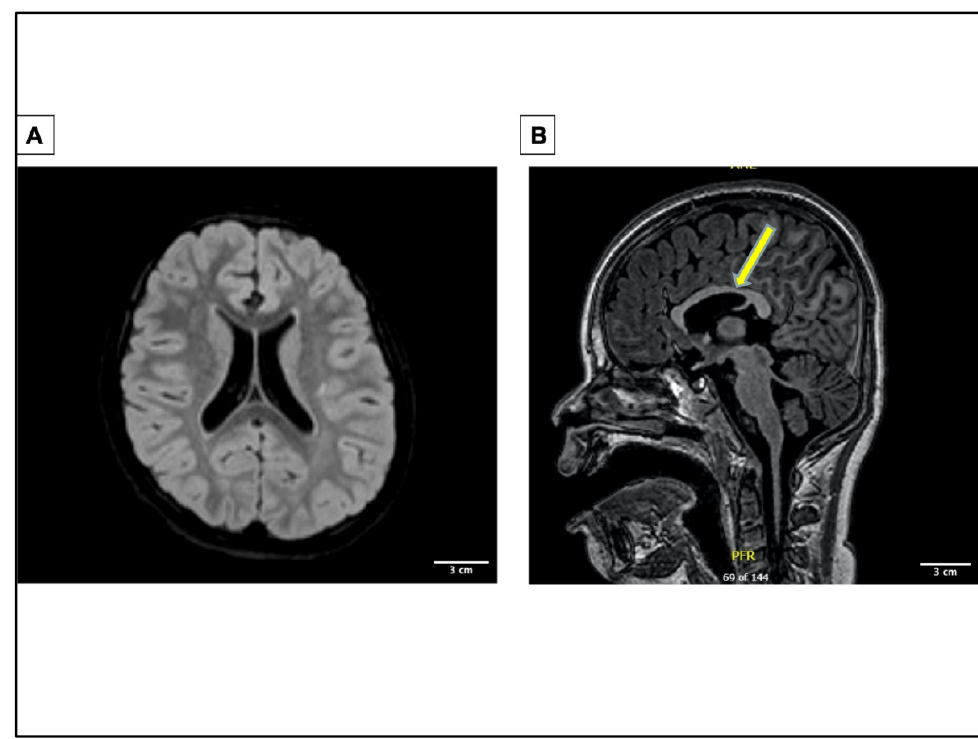
Figure 2. Brain magnetic resonance image of patient showing multifocal abnormality. Multifocal abnormality with abnormal configuration of lateral and third ventricle, suggestion of minimal infra and supratentorial volume loss, microcephaly, abnormal foliar architecture within the cerebellum, and abnormal appearance of the globes. ( A ) MRI image of transverse plane showing abnormal lateral ventricles. ( B ) MRI image of sagittal plane showing abnormal third ventricle indicated by the yellow arrow.